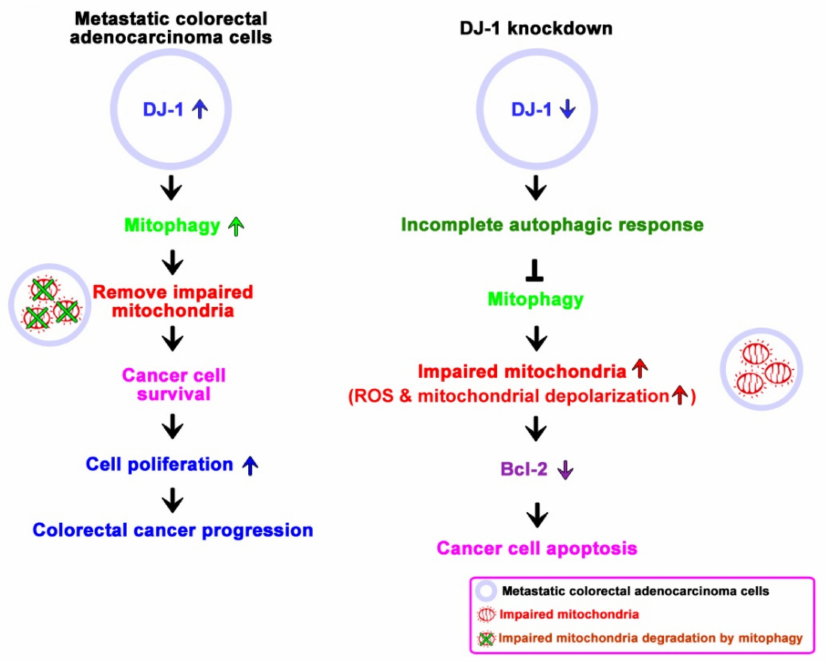
Figure 7. A proposed model shows the role of DJ-1 activates mitophagy to promote colorectal cancer progression. In metastatic colorectal adenocarcinoma cells SW620, DJ-1 activates mitophagy to remove dysfunctional mitochondria against tumor cell apoptosis. DJ-1 upregulation enhances cell survival and proliferation in metastatic colorectal adenocarcinoma cells, resulting in colorectal cancer progression. Inhibition of DJ-1 expression by DJ-1 knockdown induces an incomplete autophagic response and mitophagy inhibition that causes metastatic colorectal adenocarcinoma cells unable to remove damaged mitochondria and further induce cancer cell